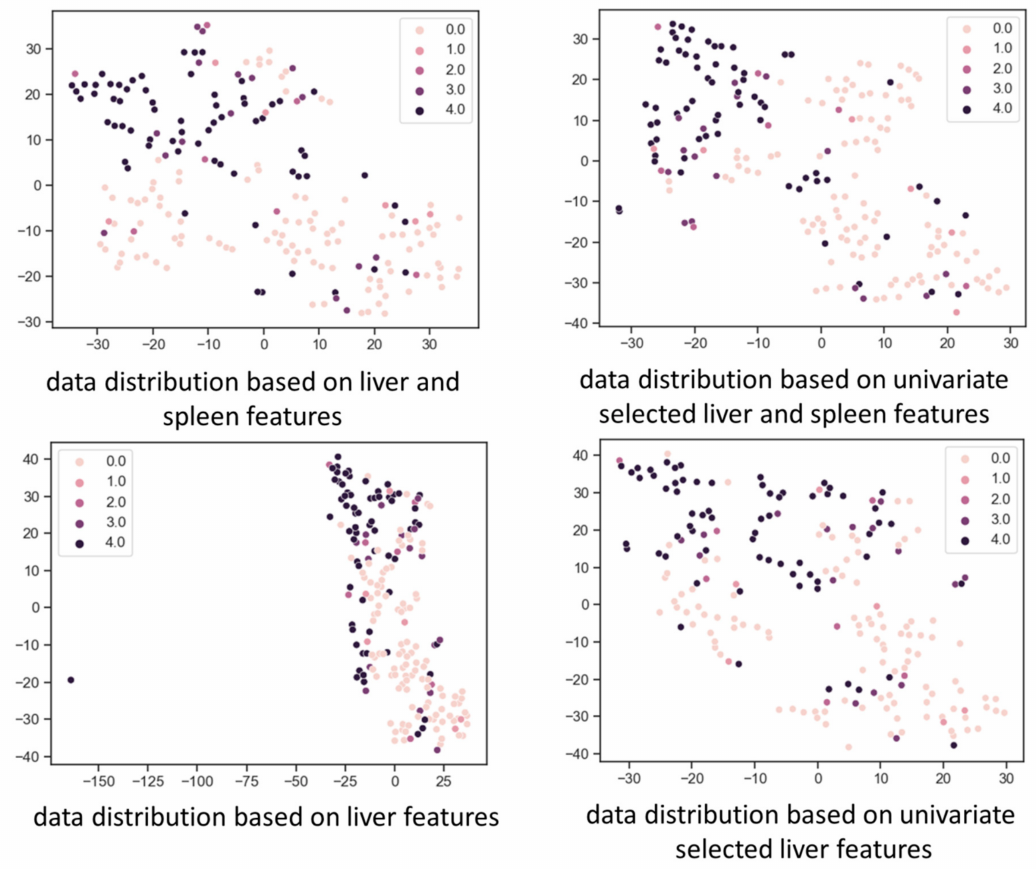
Figure 3. Data distribution based on radiomic features after dimension reduction using the t - distributed stochastic neighbor embedding ( t -SNE) method. Features are reduced to two dimensions represented by the two axes. Each dot represents a computed tomography (CT) scan, and its color represents the liver fibrosis stage as shown at the upper corner of the graph. A relative clustering of different fibrosis stages is observed, which means that CT scans of different fibrosis stages can be differentiated based on the two-dimensional features after dimension